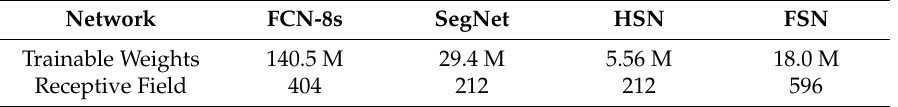
Table 8. Trainable weight and receptive field of the FCN-8s, SegNet, HSN and the proposed